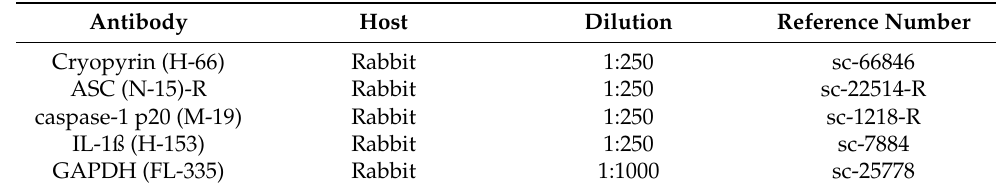
Table 3. Primary Antibodies Used in Protein Expression Assays (Santa Cruz Biotechnology, Quimigen S.L., Madrid,